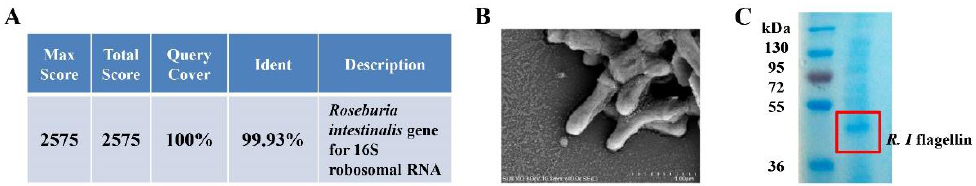
Figure A1. R. intestinalis was cultured and identified before treatment. ( A ) Strain comparison results in 16 s database. ( B ) Scanning electron microscopy of R. intestinalis . ( C ) Coomassie Brilliant Blue Staining of flagellin of R. intestinalis .